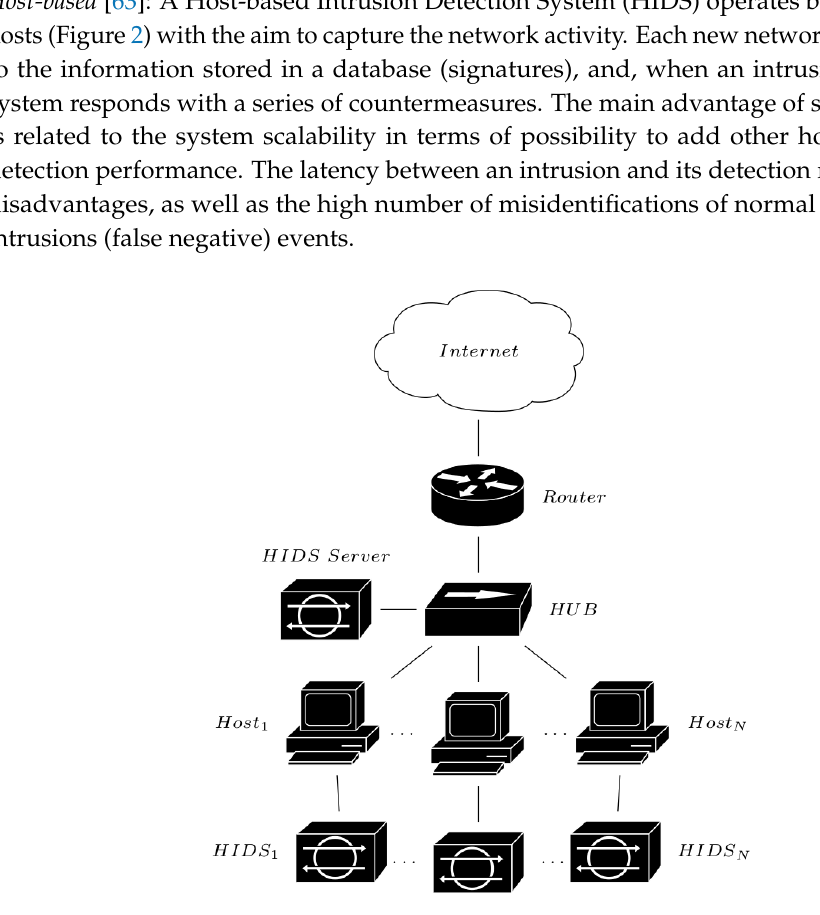
Figure 2. IDS host-based